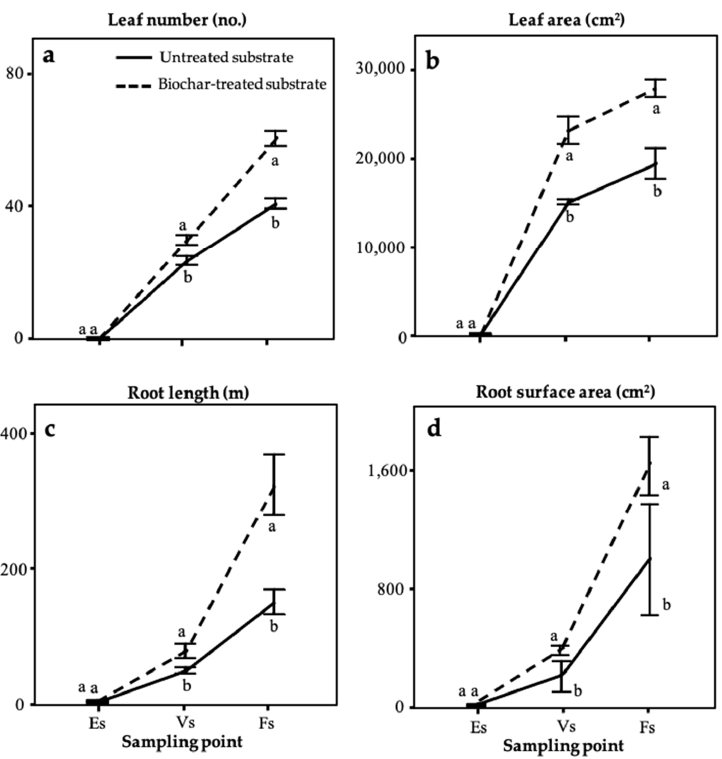
Figure 1. Leaf number ( a ) and area ( b ), root length ( c ), and surface area ( d ) were measured at the early stage (Es, 36 days after plant germination), vegetative stage (Vs, 84 days after plant germination), and fruit stage (Fs, 140 days after plant germination) of Solanum lycopersicum var. cerasiforme plants grown on the two different substrates (solid line, plants in the untreated substrate; dashed line, plants in the biochar-treated substrate). Letters indicate statistically significant differences between the two treatments inside each sampling point ( p < 0.05) ( n = 10 ± SE).